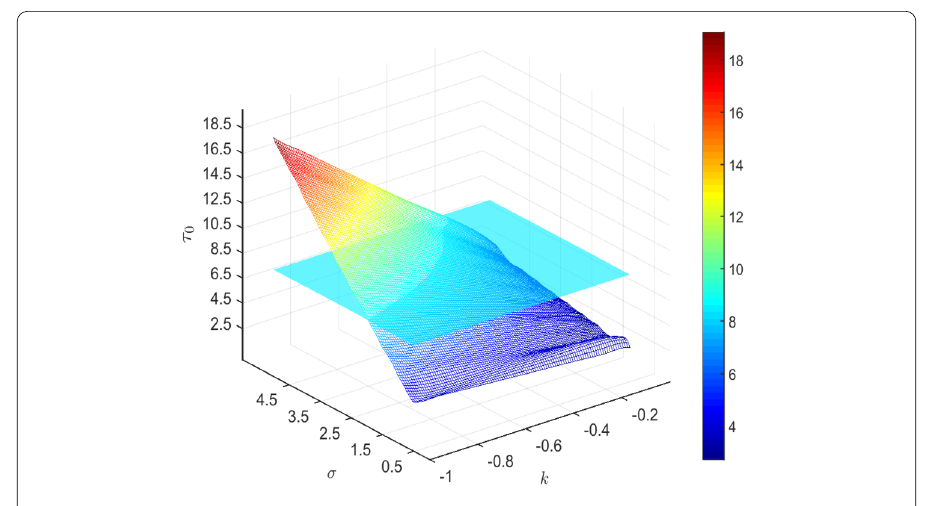
Figure 8 The joint effects of σ , k on τ ∗ 0